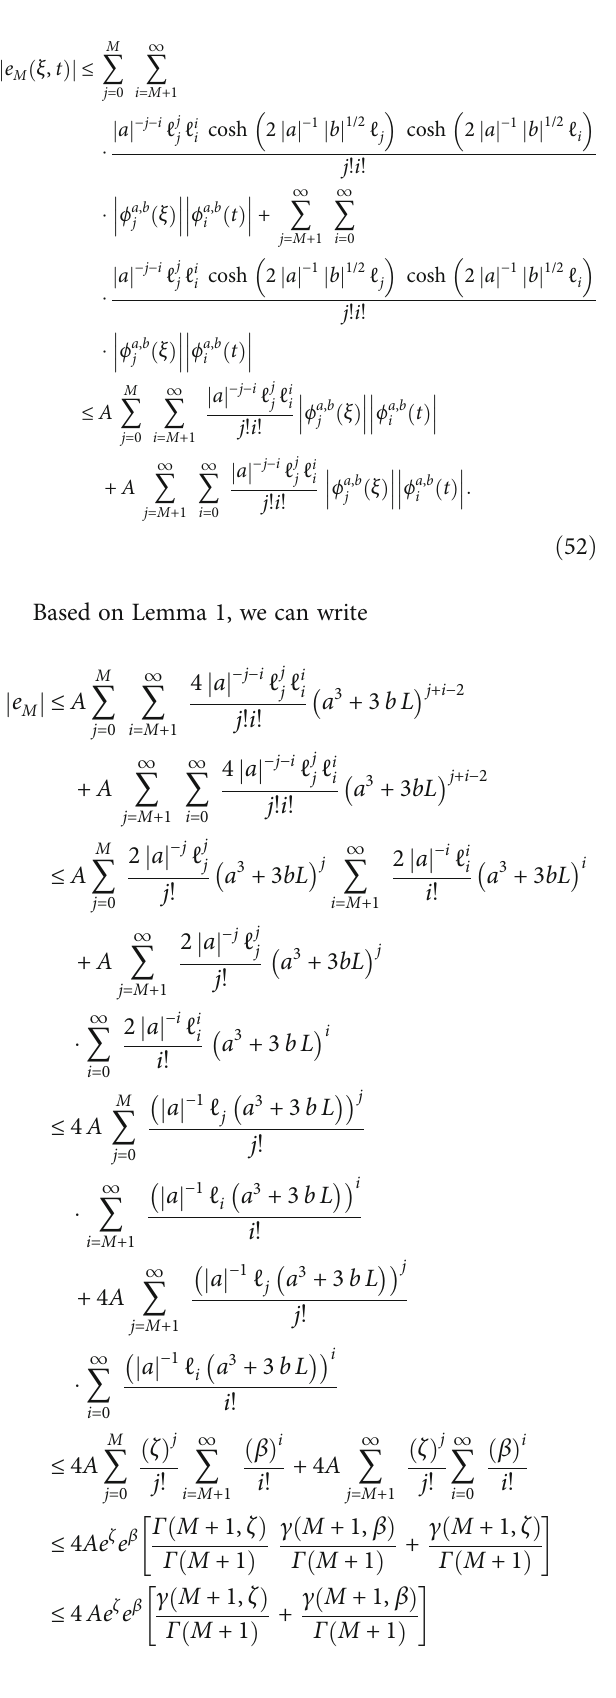
Table 1: The MAEs for Example 5 using the GLTM